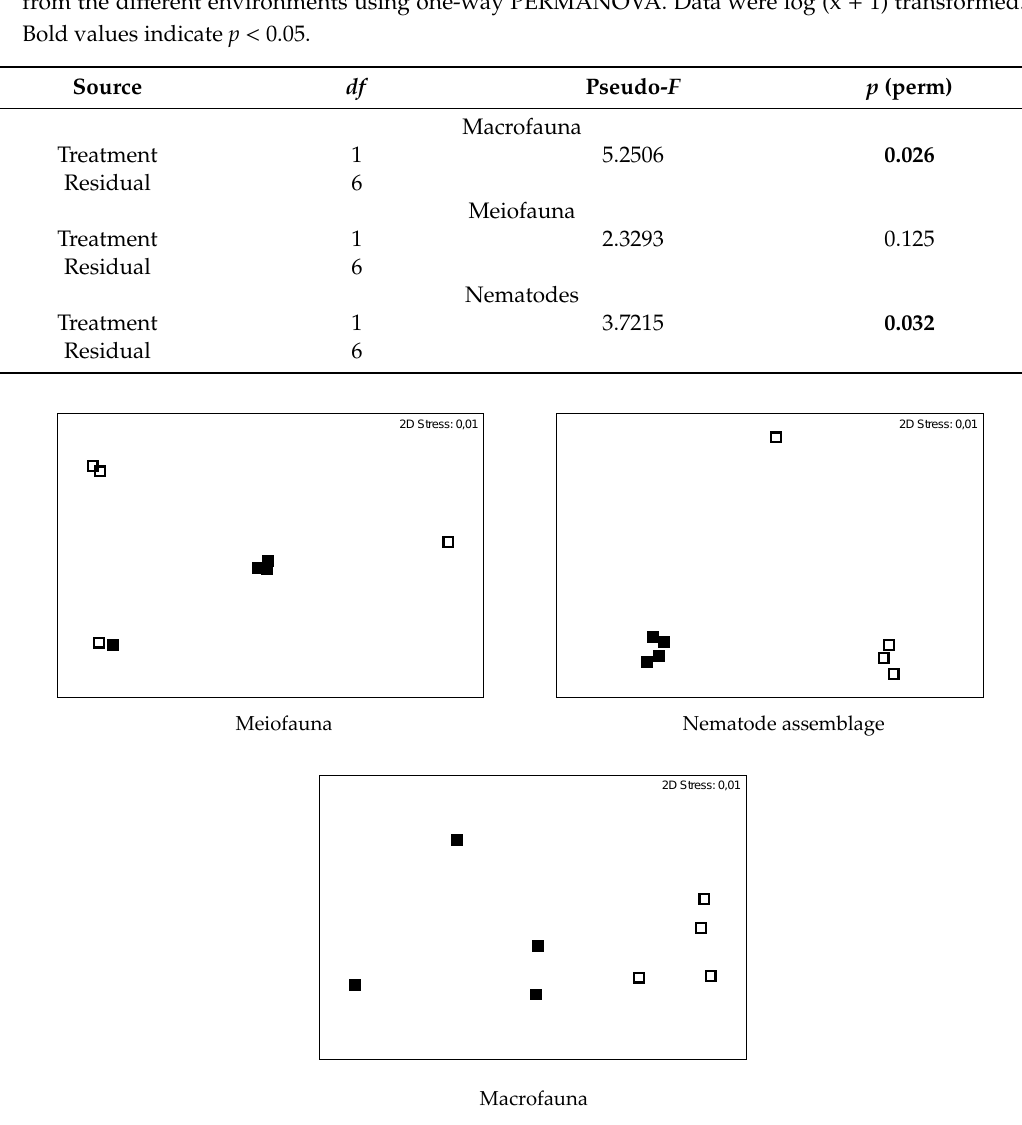
Figure 3. MDS ordination representing the similarity between samples from Bostrychia sp. from the rocky shore ( ■ ) and mangrove roots ( □ ). Data were log (x + 1) transformed.